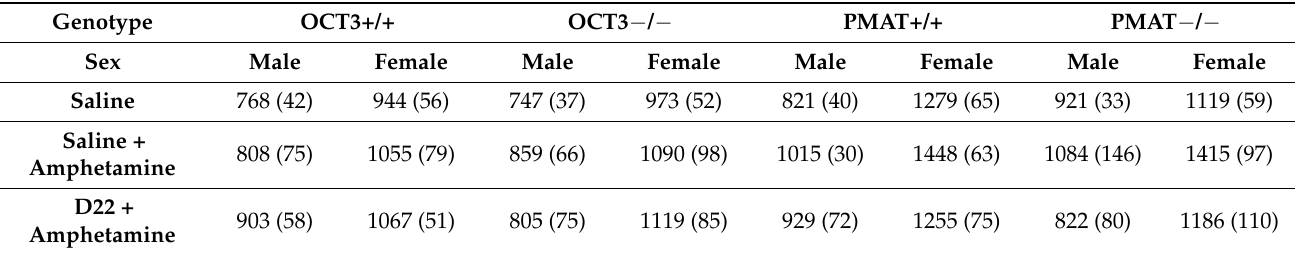
Table 1. Mean beam breaks during the first saline conditioning session and the first amphetamine conditioning session in males and females in the saline and decynium 22 (D22) pretreatment groups. Numbers in parentheses are standard error of the mean (SEM).